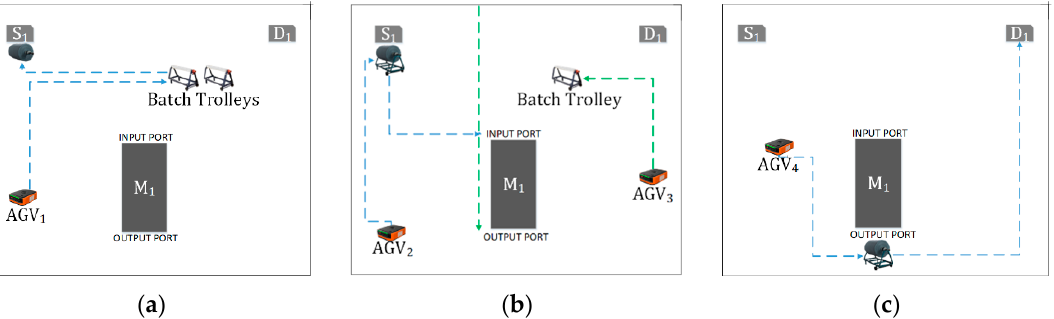
Figure 7. The scenario of the fabric included in the system at the S 1 point, processed on the (M 1 ) machine and transmitted to the (D 1 ) delivery point. ( a ) Starting task. ( b ) Input and output tasks for processing in M 1 . ( c ) The delivery task that transmits the fabric from the output port of M 1 to D 1 point.